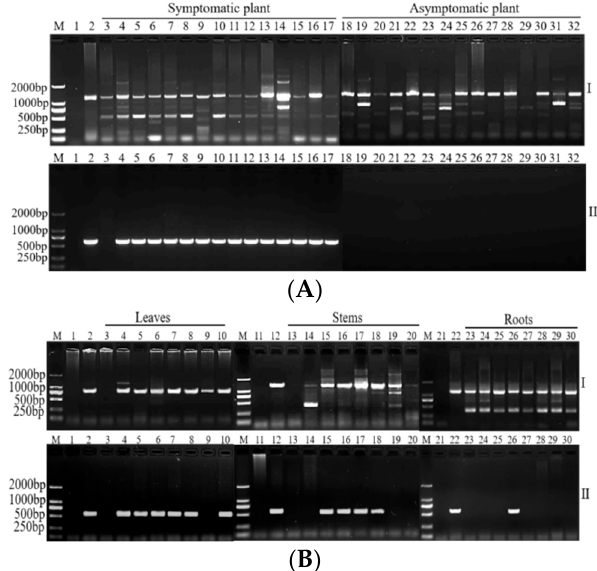
Figure 1. Results of mixed sisal samples (root, stem, and leaf) from different sampling sites ( A ) and single sisal samples (root, stem, or leaf) from plant tissue ( B ) detected via the new method (II) and conventional nested PCR (I). ( A ) Lane M: marker DL2000; lane 1: negative control; lane 2: positive